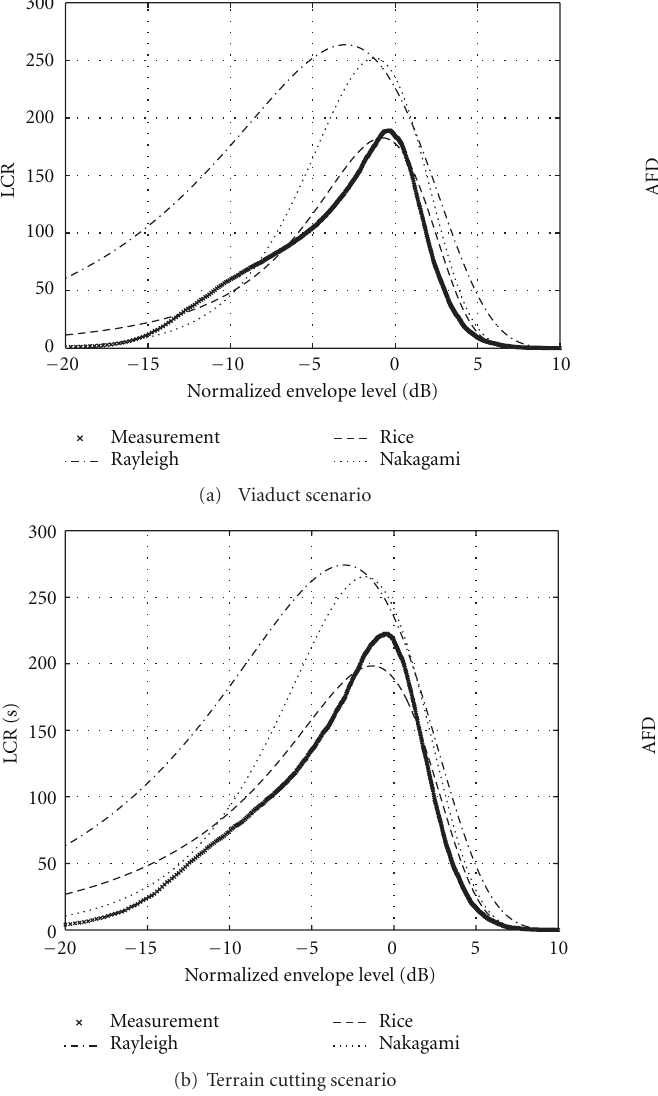
Figure 7: Empirical LCR results in both scenarios for the first measurement, together with the theoretical results of Rayleigh, Rice, and Nakagami fading models.